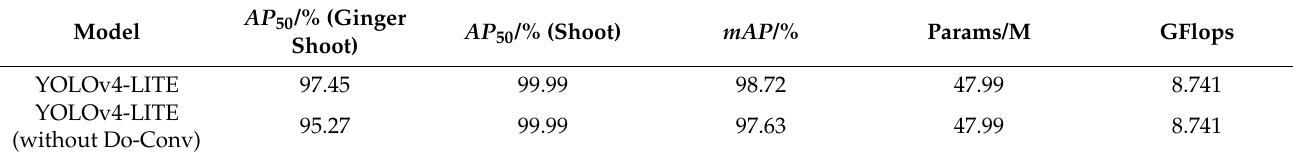
Figure 12. Loss value change curve. Table 5. Testing set experiment results using Do-Conv.